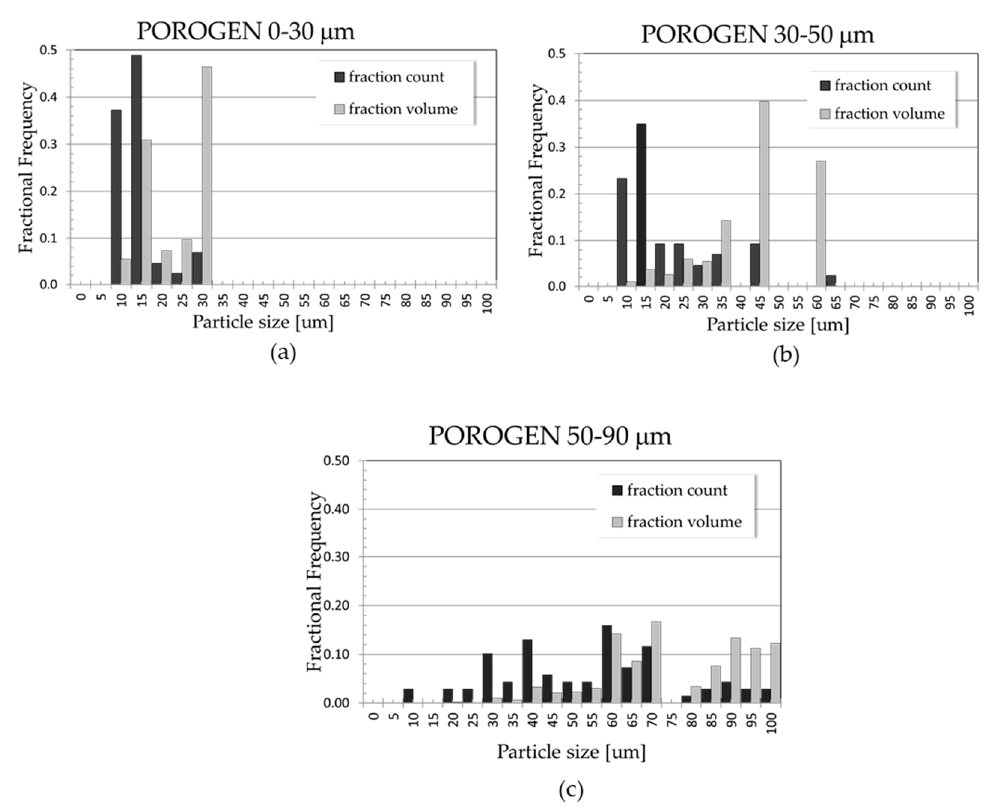
Figure 4. Porogen size distribution. Black columns—number distribution “fraction count”; grey columns—volume distribution obtained from SEM images using manual particle identification and counted using Image J. Table 3. Porogen particle size distribution and its e ff ect on the volume distribution. (a) Pore size as the diameter of an equivalent sphere. Determined from the SEM images of porogen particles; (b) volume of equivalent spheres of respective mean size; (c) the values for the two largest volume particle portions in each particle range are shown; maxima in